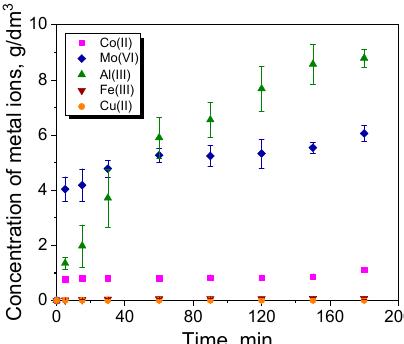
Figure 4. Change in concentration of metal ions in the leach solution during leaching for 3 h with 0.5 M H 2 SO 4 at 95 ◦ C, S / L = 1 / 20 g / cm 3